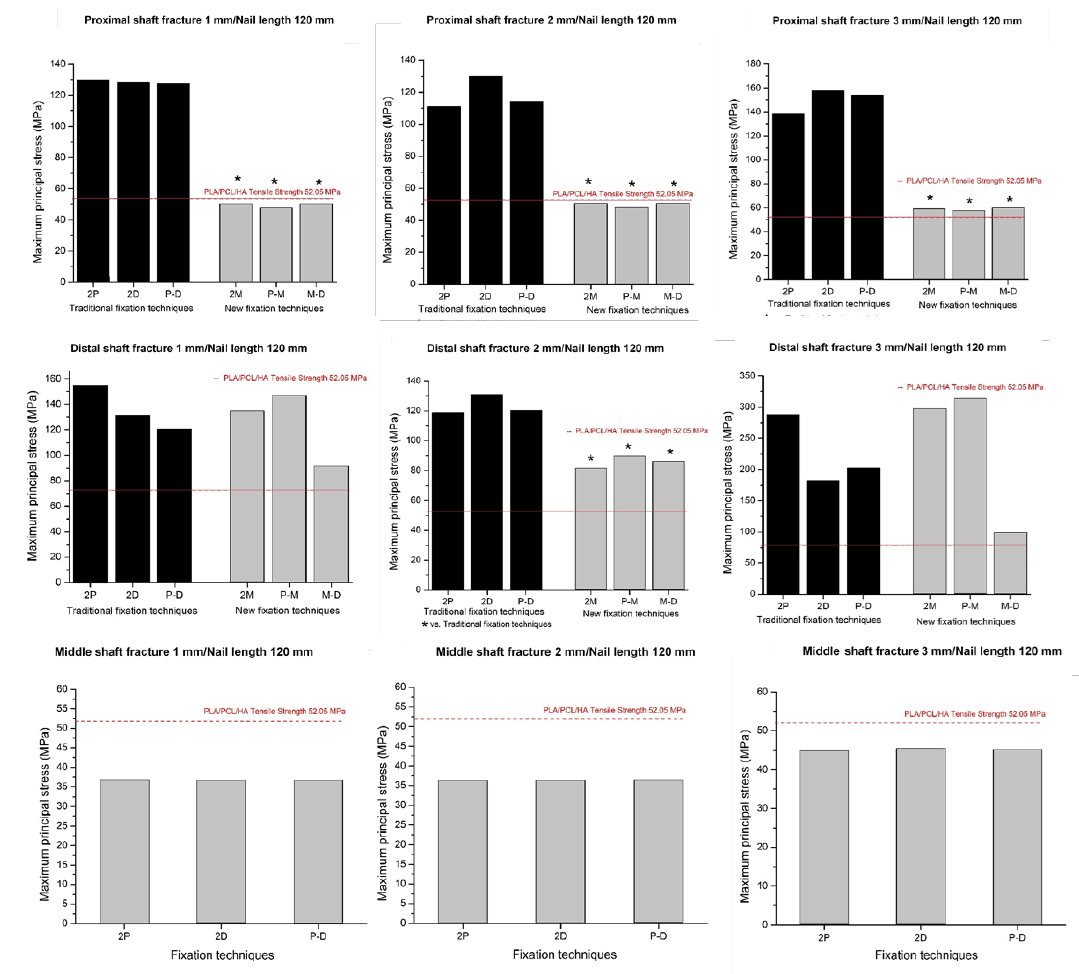
Figure 15. The maximum principal stress of the two locking screws in the composite interlocking nails with different fixation techniques and a different fracture gap in a proximal shaft fracture (top row), distal shaft fracture (middle row), and middle shaft fracture (bottom row).